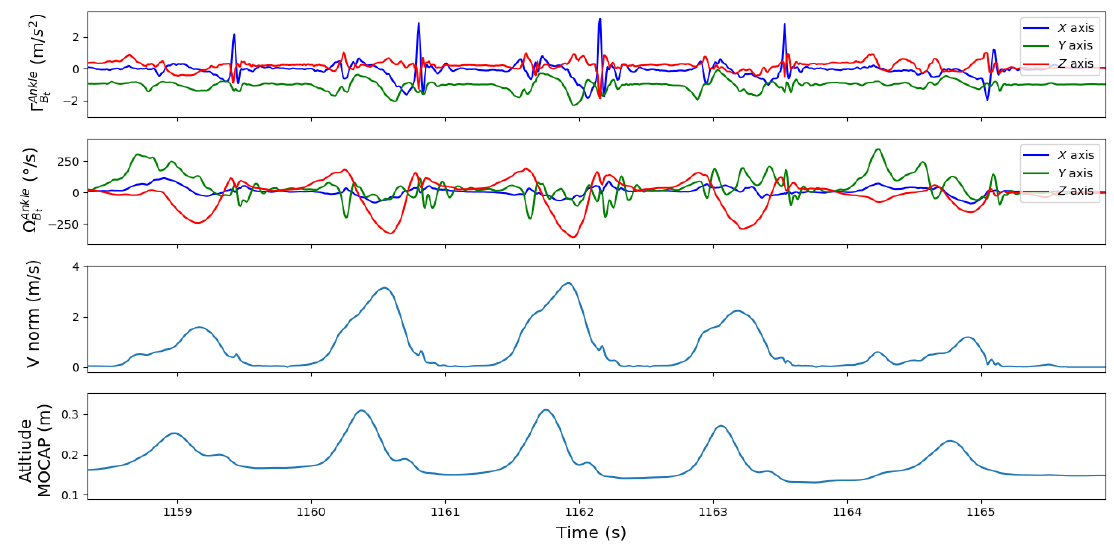
Figure A1. Pseudo-speed norm during walking.